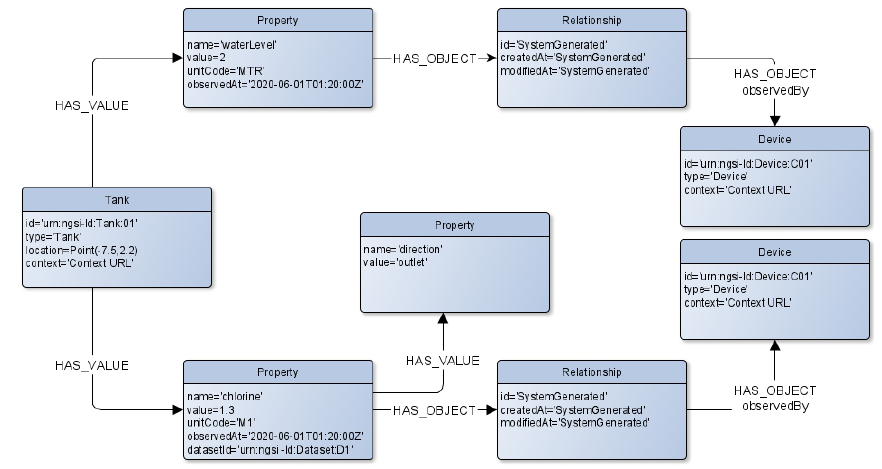
Figure 6. Mapping Tank Entity to a Named Property